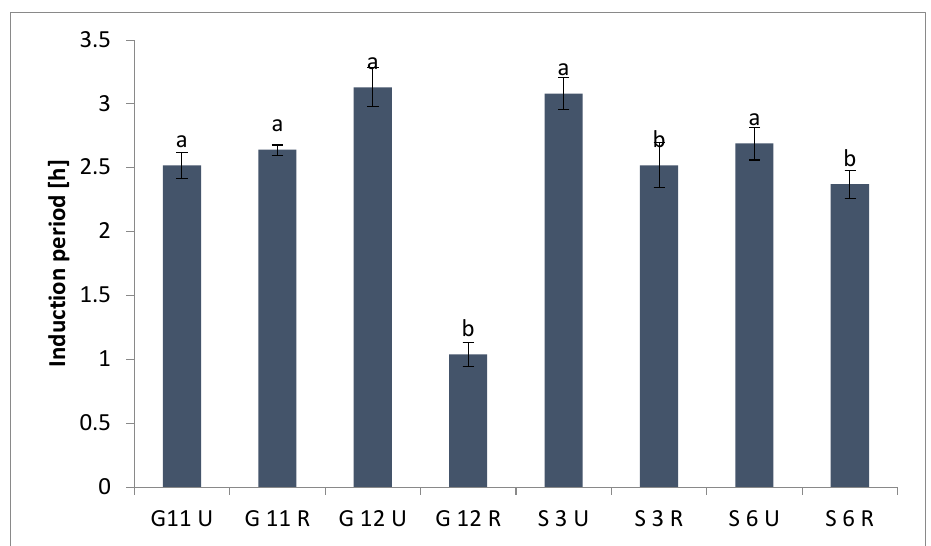
Figure 3. Induction period (h) of oil extracted from four Egyptian unroasted and roasted linseed varieties. Values with different letters ( a , b ) are significantly different ( p < 0.05).